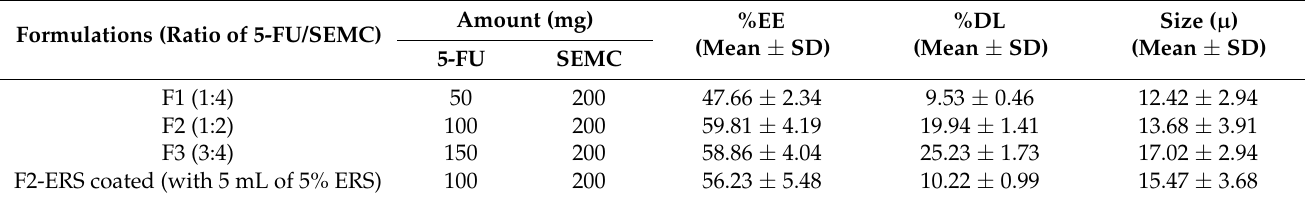
Table 1. Formulation, encapsulation, and loading of 5-FU into